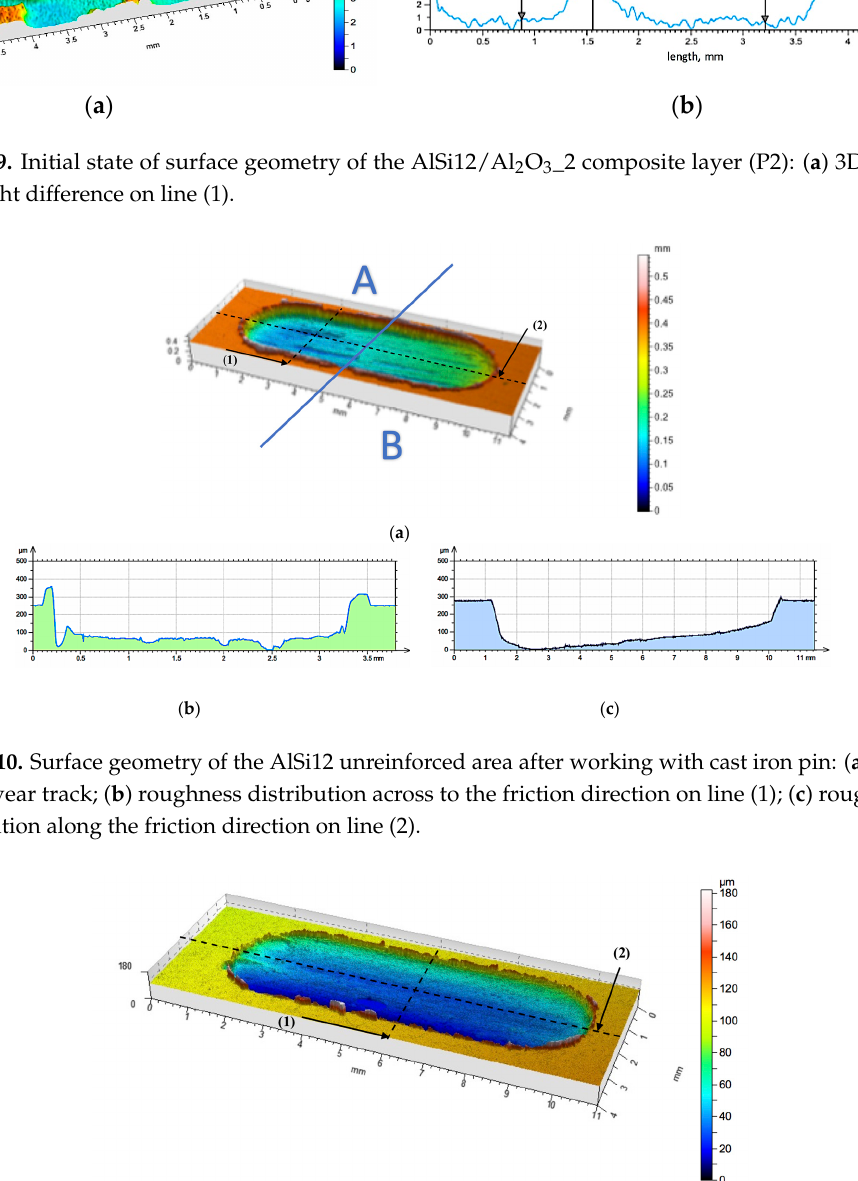
Figure 10. Surface geometry of the AlSi12 unreinforced area after working with cast iron pin: ( a ) view of the wear track; ( b ) roughness distribution across to the friction direction on line (1); ( c ) roughness distribution along the friction direction on line (2).